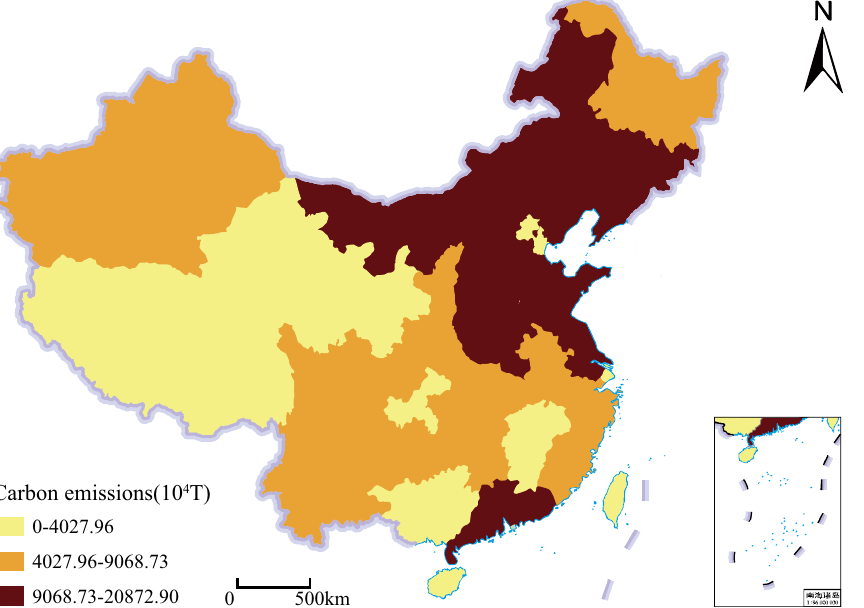
Figure 7. Distribution of provincial carbon emissions in 2010. This map is based on the standard map No. GS(2019) 1825 downloaded from the Ministry of Natural Resources Standard Map Service website. The base map is